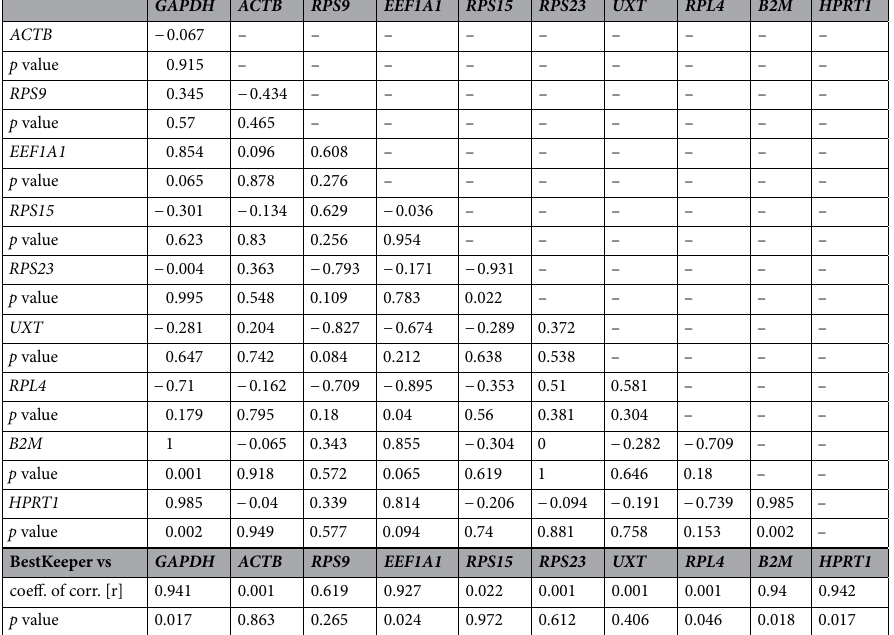
Table 9. Analysis of repeated pair-wise correlation amongst genes in LAD with BestKeeper index.